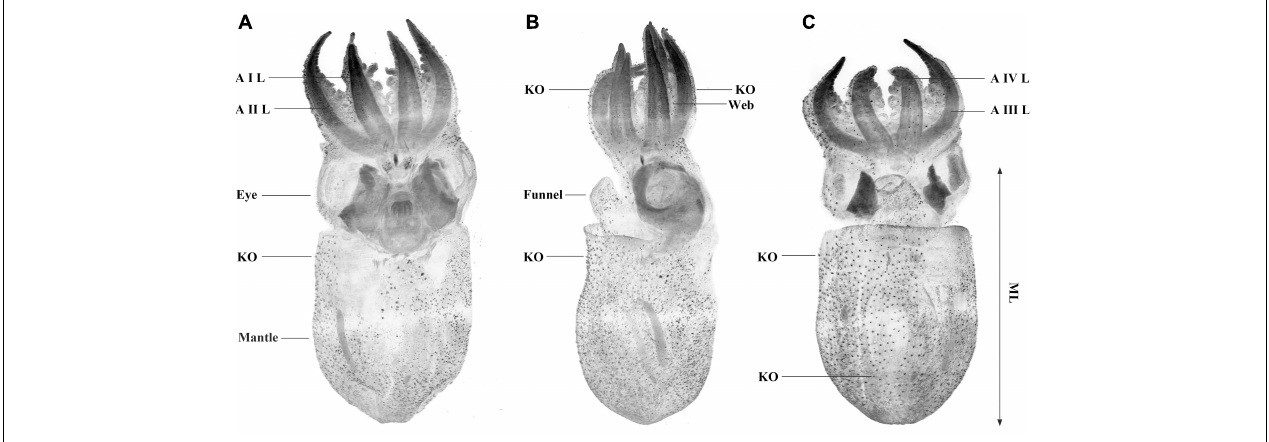
FIGURE 2 | Octopus vulgaris SPIM images from an individual aged 30 days (ML 3.8 mm). Individual labeled with Evans blue and excited at 638 nm. Dorsal (A) , lateral (B) , and ventral (C) max projection views with contrast enhanced and inverted. Note the Kölliker’s organs (KO) on the skin as black, awl-shaped forms distributed over the mantle, head, funnel, arms, and web. Minor black spots also covering the skin probably are mineral salts associated with the preservation of the sample. Arm I left (AIL), arm II left (AIIL), arm III left (AIIL), and arm IV left (AIVL), are indicated. ML in octopods is measured from midpoint between the eyes to posterior end of